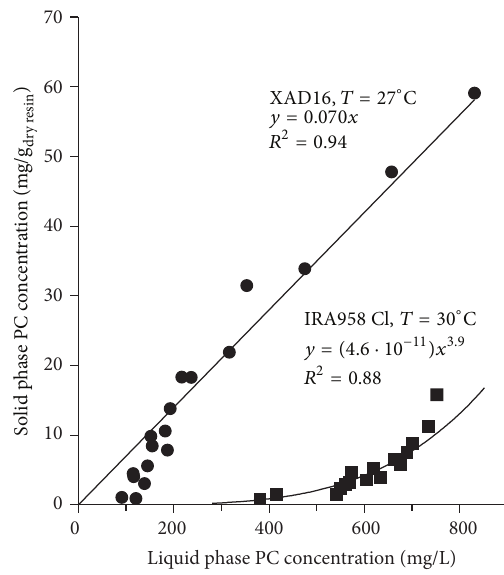
Figure 1: Isotherm tests conducted with resins XAD16 and IRA958 Cl: experimental data and best-fitting